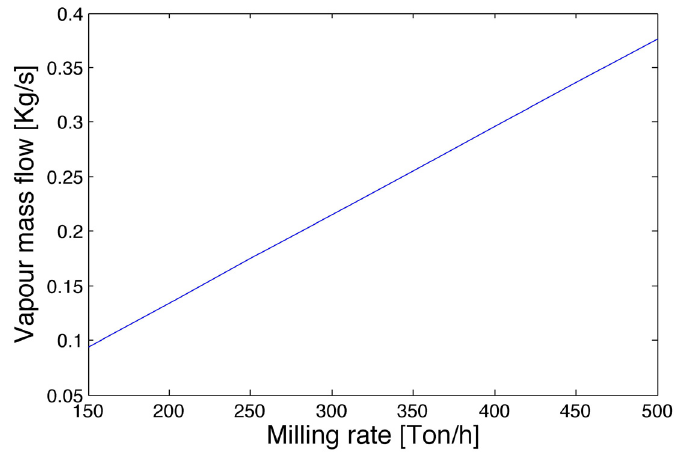
Figure 5. Steam mass rate through the 21.7 to 2.7 bar reduction station.